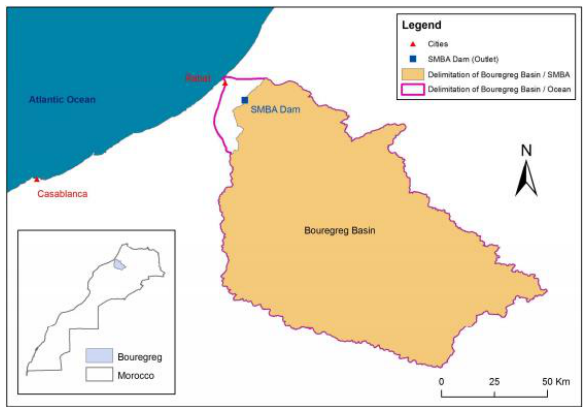
Figure 1.Map of Bouregreg